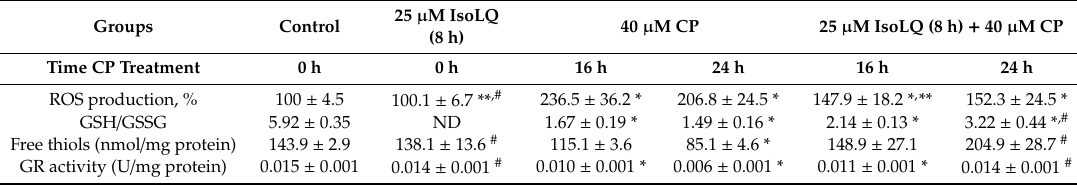
Table 1. E ff ect of isoliquiritigenin (IsoLQ)-induced hormesis on oxidative stress in LLC-PK1 cells after 16 and 24 h of cisplatin (CP) treatment.